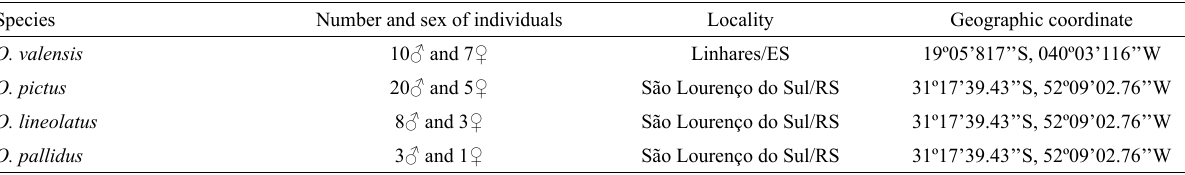
Table 1 – Specimen information and number of samples.